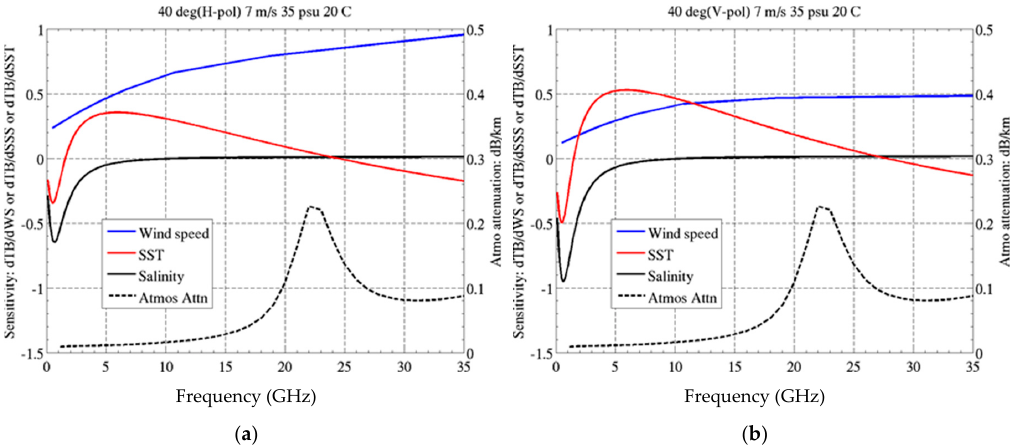
Figure 13. Sensitivity of brightness temperature to WS (blue), SST (red) and SSS (black) for 40 ◦ incidence, WS = 7 m / s, SSS = 35 psu and SST = 20 ◦ C. The figures also indicate attenuation due to the atmosphere (dashed line). For attenuation, the vertical axis is attenuation in dB per km at nadir. ( a ) Horizontal polarization; ( b ) Vertical polarization.